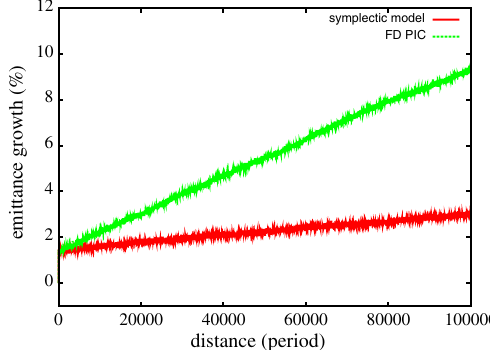
FIG. 5. Four dimensional emittance growth evolution from the symplectic multiparticle spectral model (red) and from the PIC finite difference